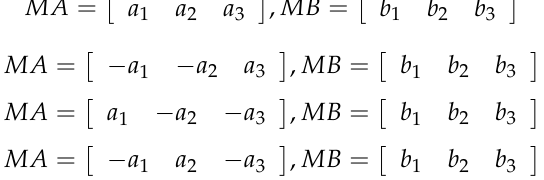
Figure 6. Schematic diagram illustrating the PCA method. ( a ) MASs of two fracture surfaces; ( b ) registration of two MASs; ( c ) fracture surfaces registration; ( d ) fragments registration.